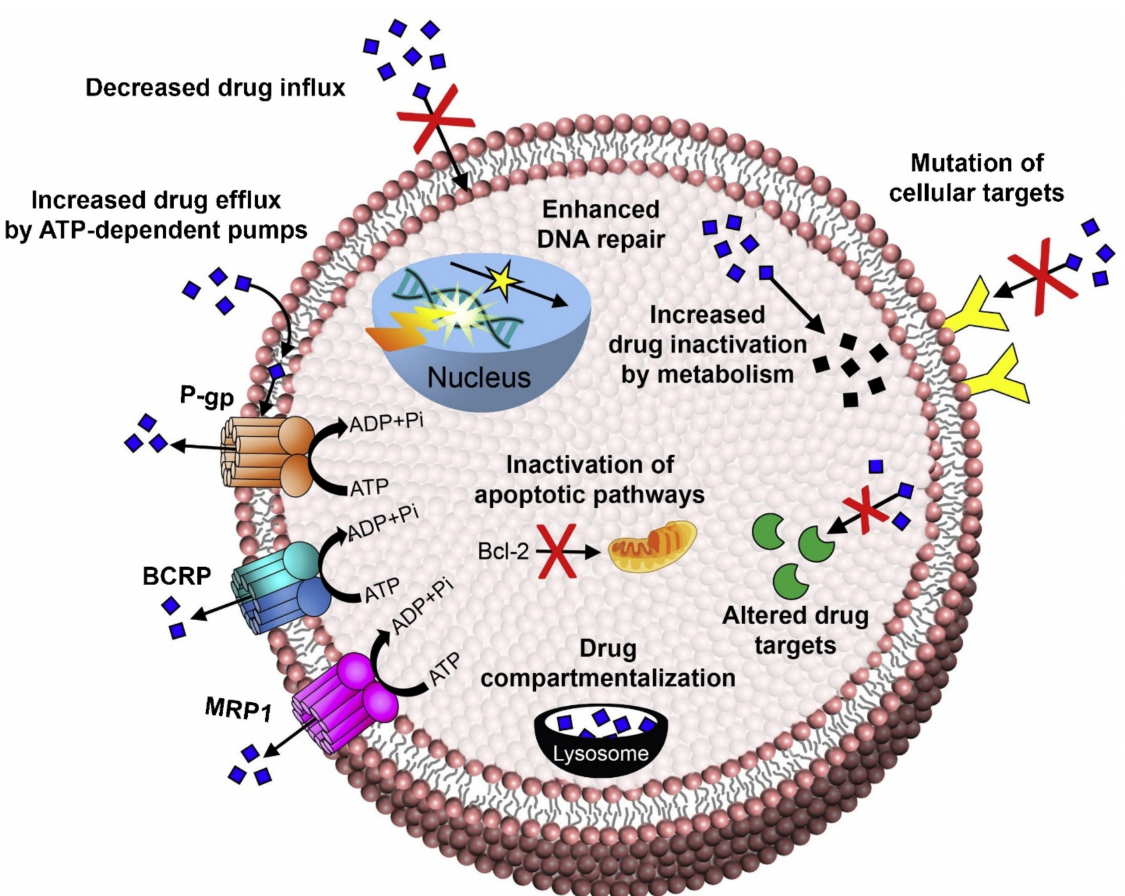
Figure 3. Mechanisms of drug resistance, including efflux pump-mediated mechanisms of MDR and efflux pump- independent drug resistance mechanisms [25]. The figure depicts how efflux transporters, including P-gp, BCRP, and MRP-1, efflux drugs and other xenobiotics from the cells. Cancer cells can develop drug resistance by increasing the expression of drug metabolizing enzymes and, hence, inactivating the drugs. Similarly, resistance can be developed by the cells by altering drug targets, rendering the drugs inactive. Drug compartmentalization into lysosomes causes drug inactivation and acquired drug resistance by cancer cells